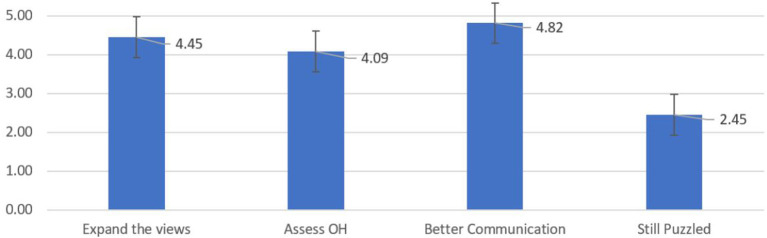
Results of final assessment. Scale from 1 = disagree to 5 = agree.